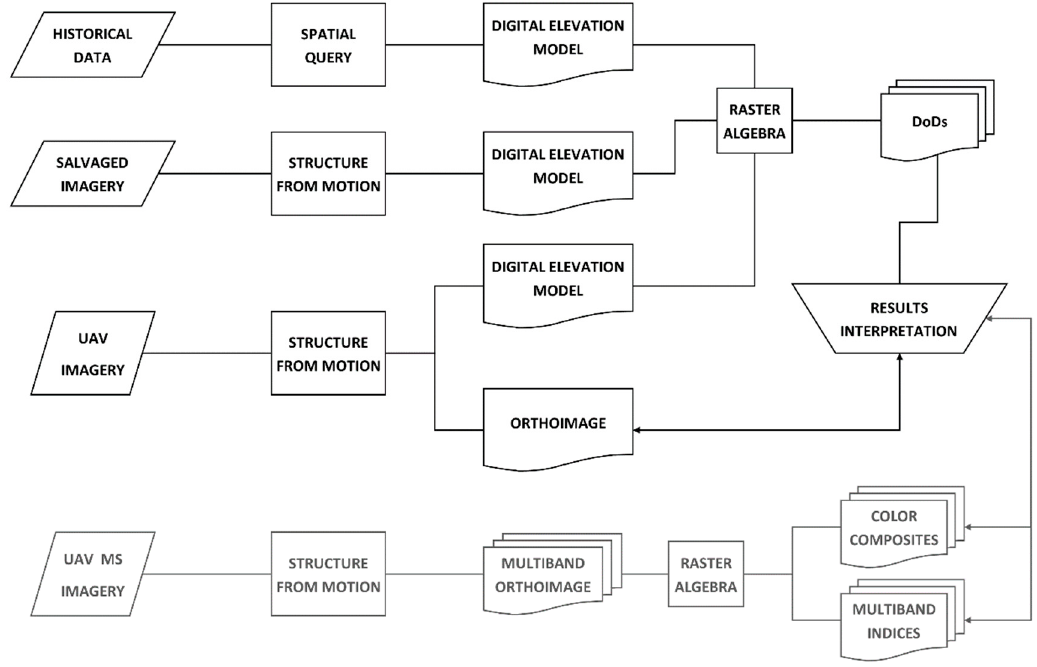
Figure 2. Workflow of the proposed methodology, the grey sector was only carried out with an experimental approach.